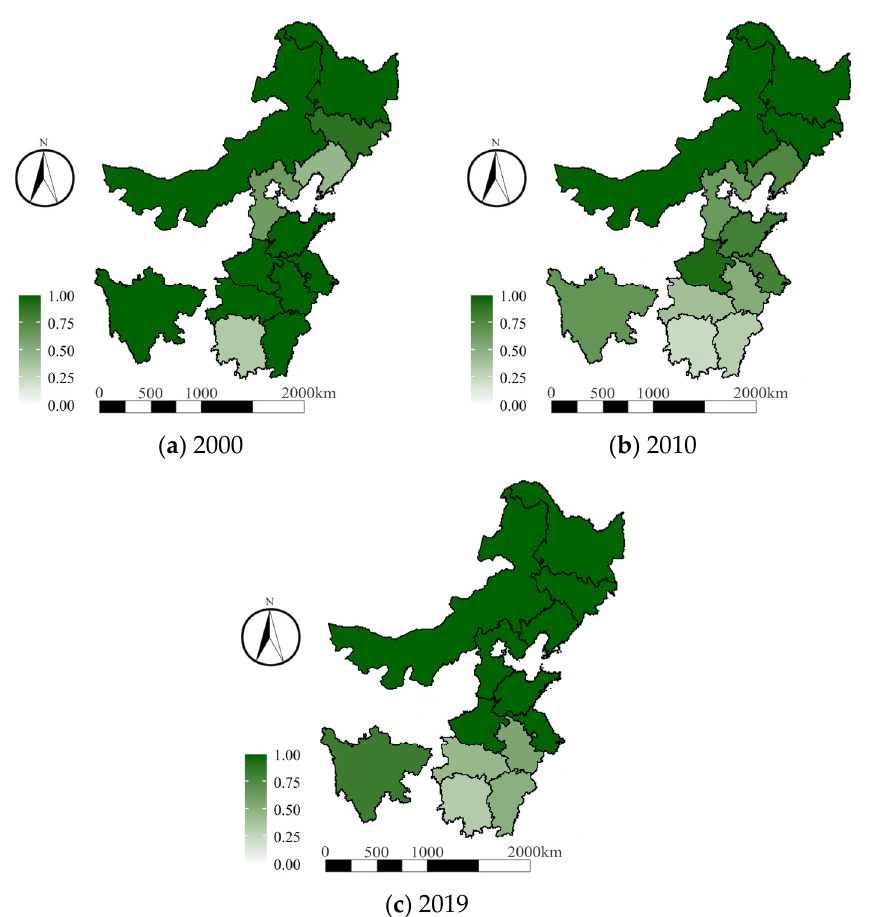
Figure 7. Spatial distribution of the NCSPC in the principal grain-producing area of China in major years.